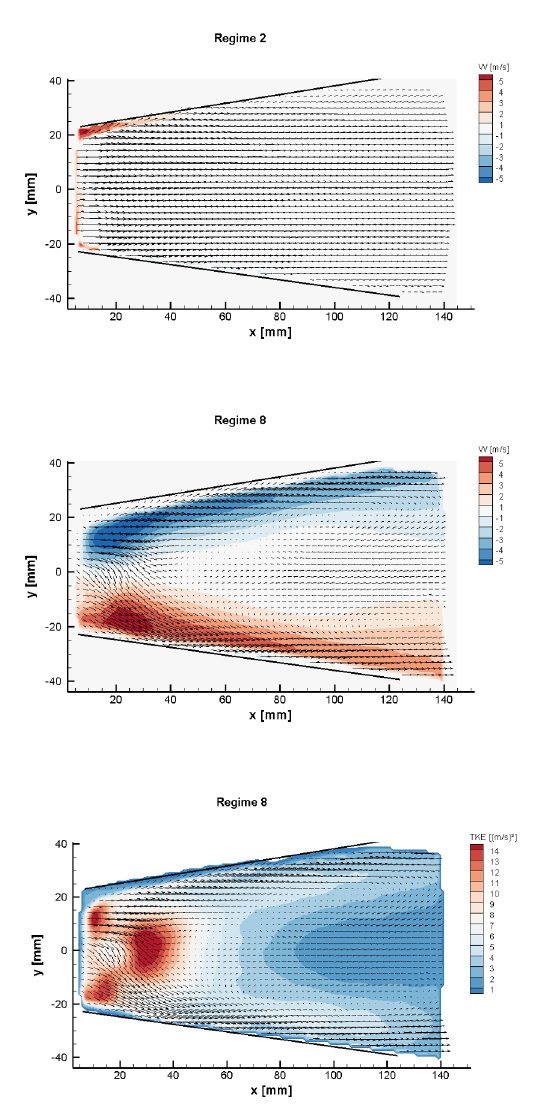
Fig. 2a, b, c. Longitudinal planes, distributions of out-of-plane velocities (a, b) and turbulent kinetic energy (c) .